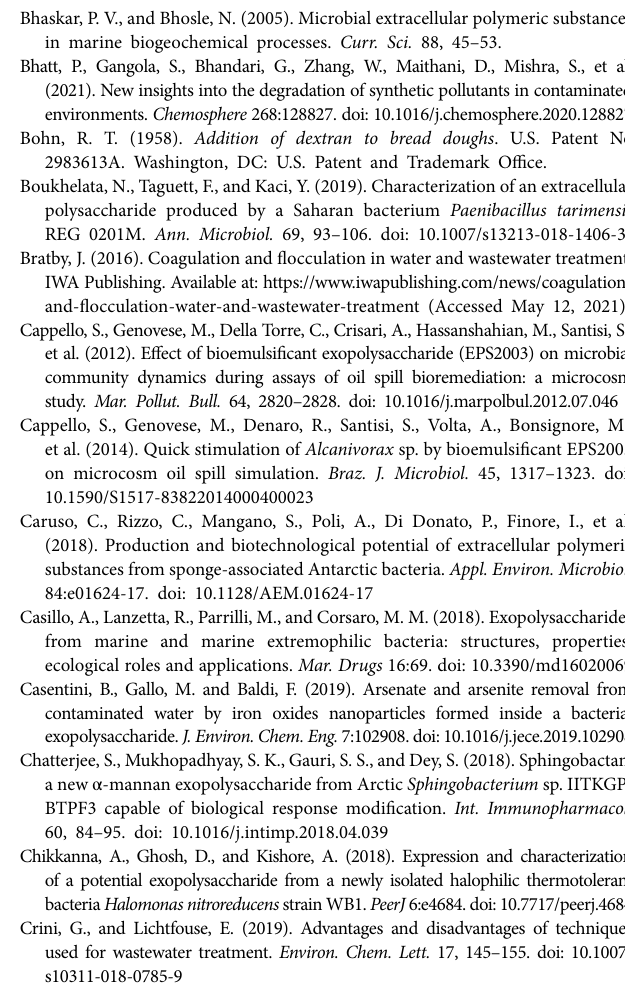
Supplementary Figure 1 | Various applications of microbial exopolysaccharides (EPS) in biotechnology. Supplementary Figure 2 | Overview on EPS producing